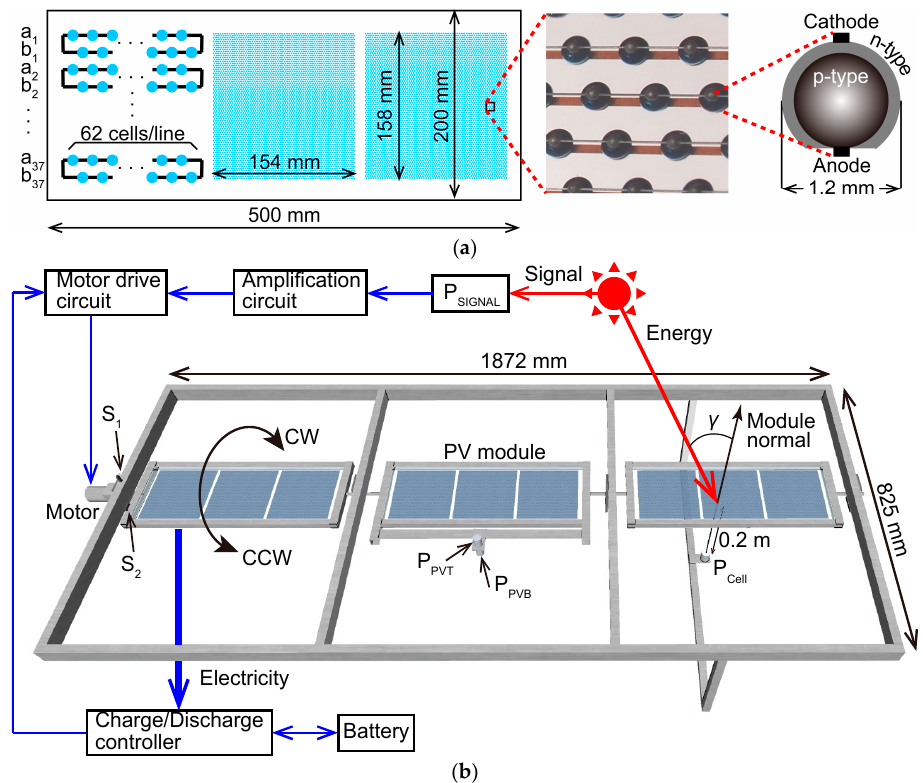
Figure 1. Semi-transparent photovoltaic (PV) module as a venetian-blind-blade for the greenhouse shading application: overview of the PV module with close-up photograph and cross-sectional structure of the spherical Si-PV cell; ( a ): block diagram of the prototype PV blind system ( b ): P PVT and P PVB are pyranometers facing opposite directions to measure the total incident irradiance on the bifacial PV module. S 1 and S 2 are mechanical switches to stop the module rotation at the perpendicular or parallel position to the greenhouse roof when the module contacts with S 1 or S 2 . Table 1. Specifications of the semi-transparent photovoltaic (PV) module used as the blind blade